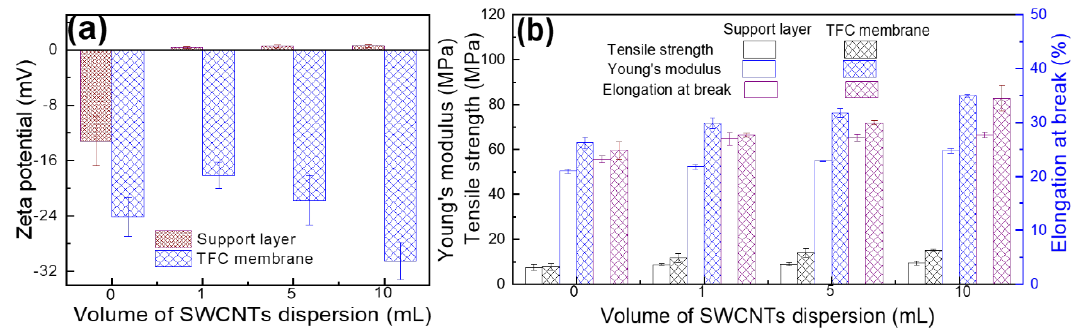
Figure 5. ( a ) Surface zeta potential and ( b ) mechanical properties including tensile strength, Young’s modulus and elongation at break.